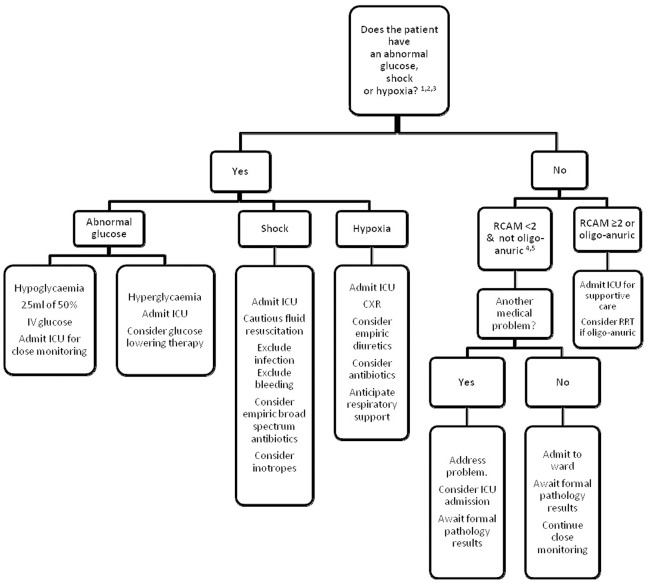
Proposed initial triage strategy for an adult with falciparum malaria in a resource-poor setting.
1Shock: systolic blood pressure <80 mmHg with cool peripheries. 2Hypoxic: SaO2≤95% using pulse oximetry. 3Abnormal blood glucose: blood glucose <3.5 mmol/L or ≥12 mmol/L using glucometer. 4RCAM (see table 1). 5Oligo-anuric: urine output <10 ml first hour after catheterization.